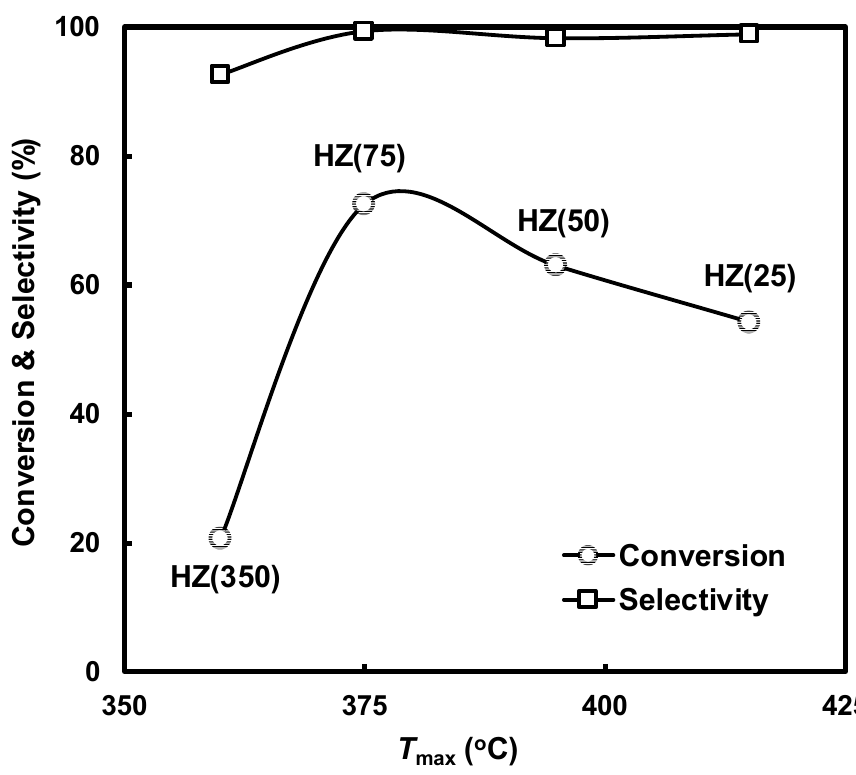
Figure 9. Dependence of catalytic activities of the HZSM-5 zeolite to their acid strength in the acetylation reaction.